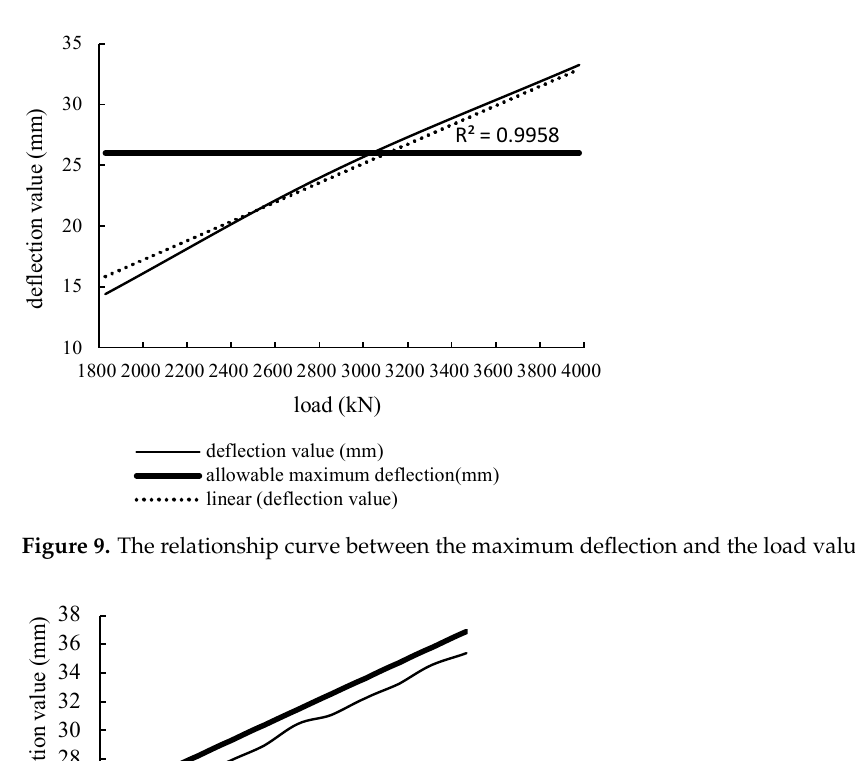
Table 6. Operation sorties in 1–20 years at different growth rates.